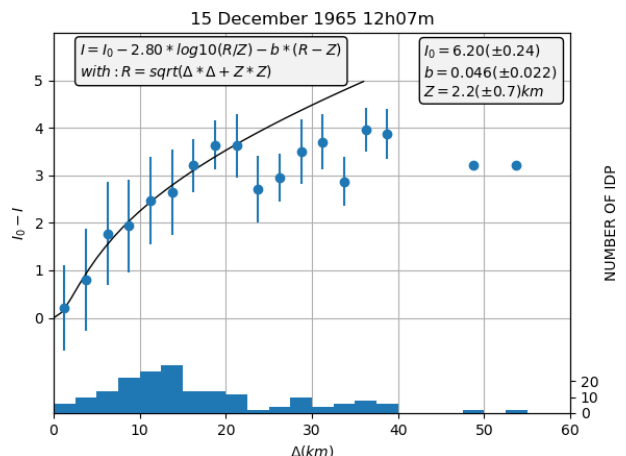
Figure 4. Intensity attenuation of the 15 December 1965 Strépy- Bracquegnies earthquake expressed as mean intensity change rel- ative to I 0 (blue dots) calculated for bins of 2.5km (histogram). Vertical blue bars show the intensity standard deviations for each distance bin that expresses the intensity variability in the bin. The legend reports local parameters fitting the intensity attenuation of Eq. (1), with the a parameter fixed to